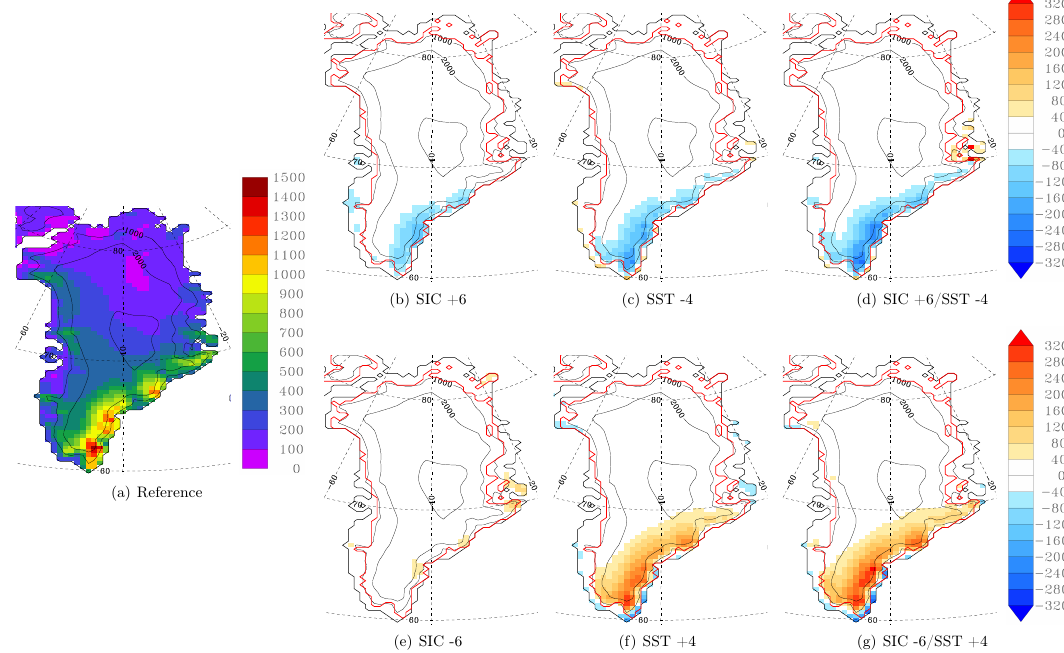
Figure 2. Annual mean cumulated snowfall (mmWEyr − 1 ) for the reference run (a) , using the MAR model over 2007–2012. Difference in annual mean cumulated snowfall (mmWEyr − 1 ) between (b) SIC + 6, (c) SST − 4, (d) SIC + 6/SST − 4, (e) SIC − 6, (f) SST + 4, (g) SIC − 6/SST + 4 experiments and the reference run. The thick red line defines the GrIS area in MAR.